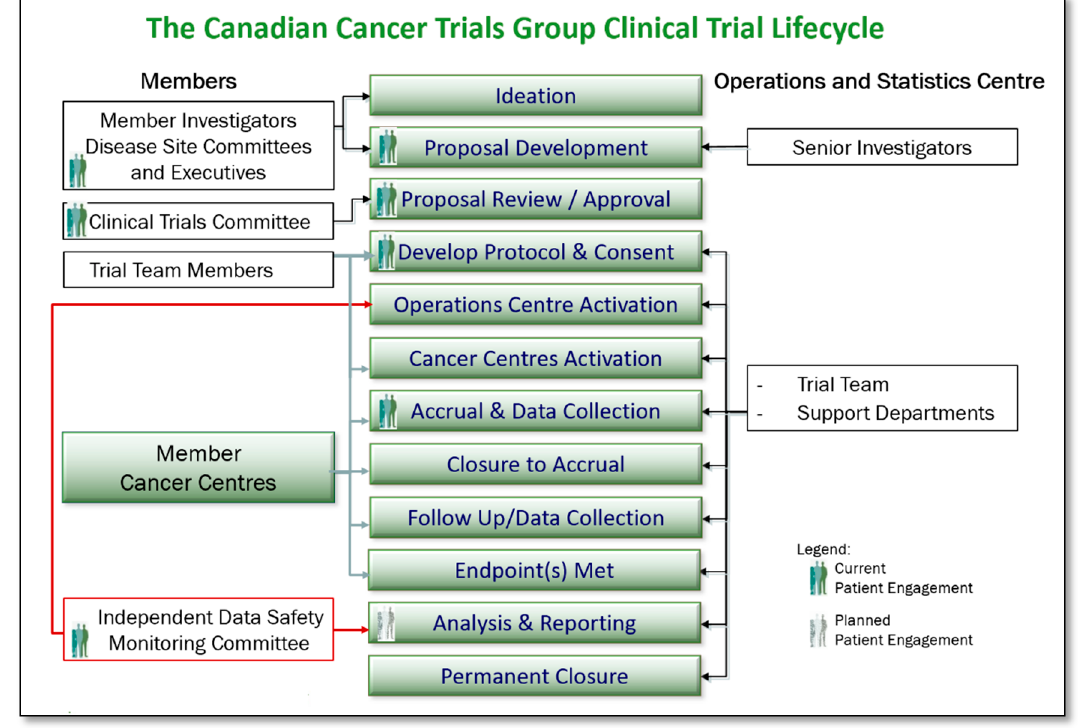
Figure 5. Patient Engagement in The Canadian Cancer Trials Group Clinical Trial Lifecycle.